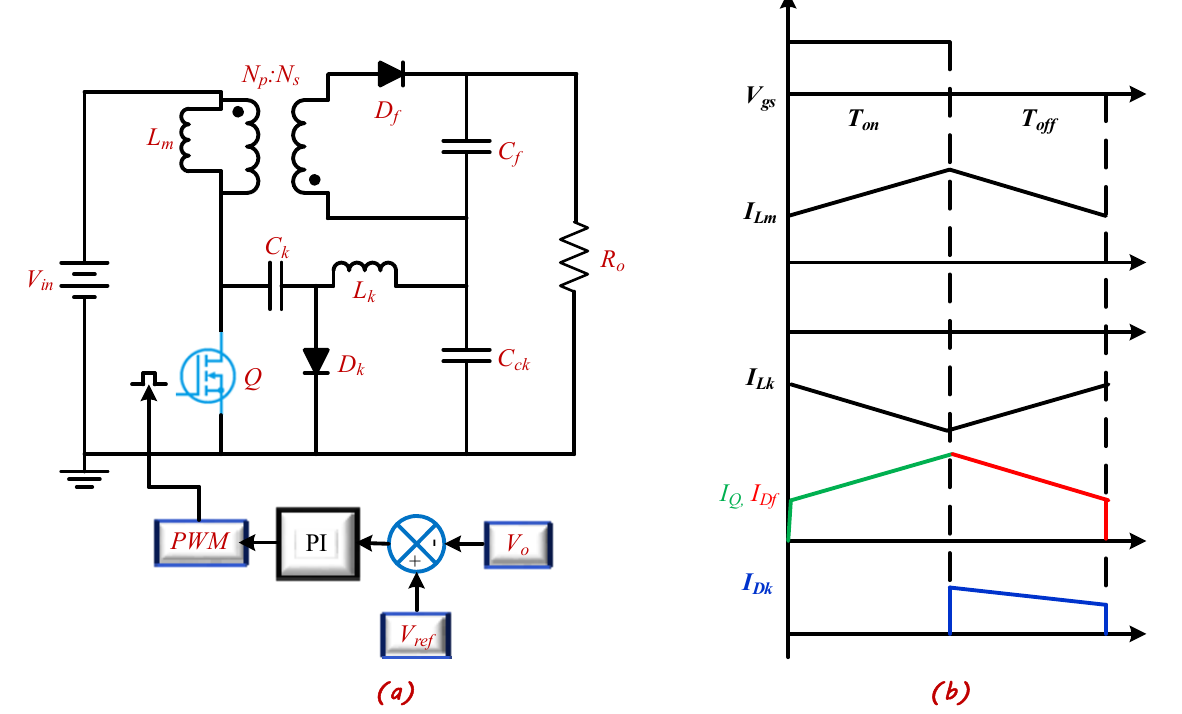
Figure 2. ( a ) The proposed HFC converter with the voltage control loop, ( b ) key